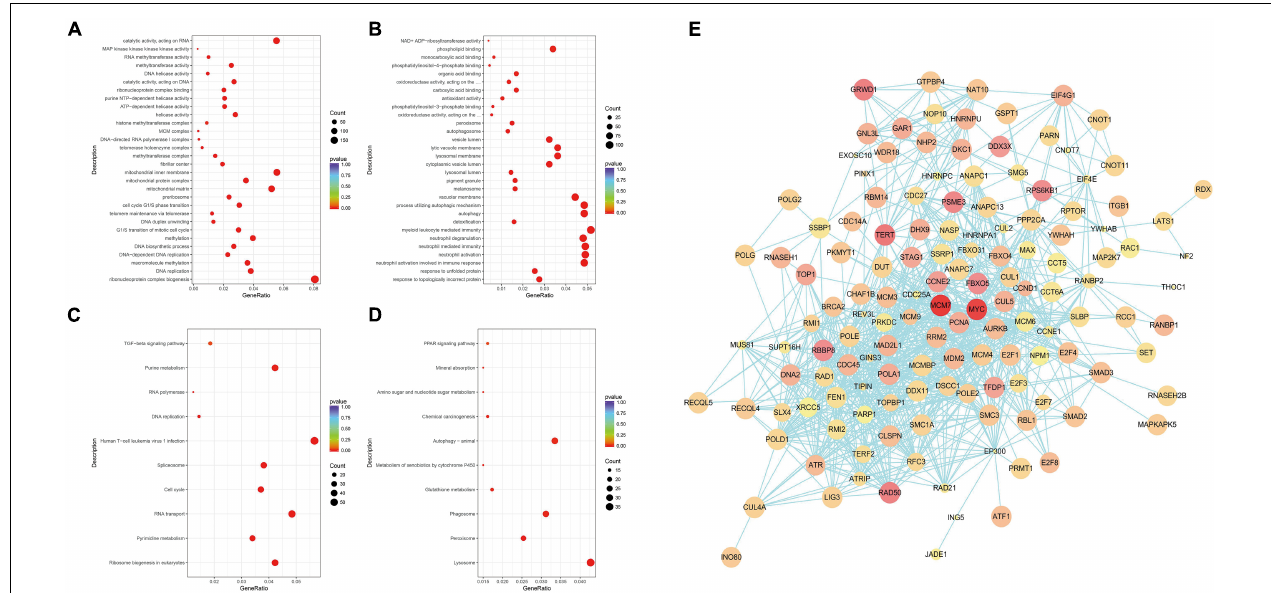
FIGURE 3 | Gene Ontology (GO) and Kyoto Encyclopedia of Genes and Genomes (KEGG) enrichment analysis of differentially expressed genes (DEGs) and protein–protein interaction (PPI) network analysis. (A) Scatterplots of down-regulated DEGs with GO enrichment in biological processes, cell components, and molecular functions. (B) Scatterplots of up-regulated DEGs with GO enrichment in biological processes, cell components, and molecular functions. (C) Scatterplots of down-regulated DEGs with KEGG pathway enrichment. (D) Scatterplots of up-regulated DEGs with KEGG pathway enrichment. The degree of GO or KEGG enrichment was measured by the rich factor, p -value, and the number of genes enriched on this term. The rich factor refers to the ratio of the number of DEGs (sample) to the number of annotated genes (background) in the term. A term with a p < 0.05 is considered an enriched term, and 30 of the most enriched GO terms are shown, whereas 10 of the most enriched KEGG pathways are shown. The size of the dot indicates the number of DEGs. (E) PPI network analysis of DEGs. Nodes and edges represent genes and interactions among genes, respectively. The red shade represents the value of log2(fold change), which means the deeper the red is and the larger the log2(fold change) is; the size of the node represents the p -value, which means the larger the node is, the smaller the p -value